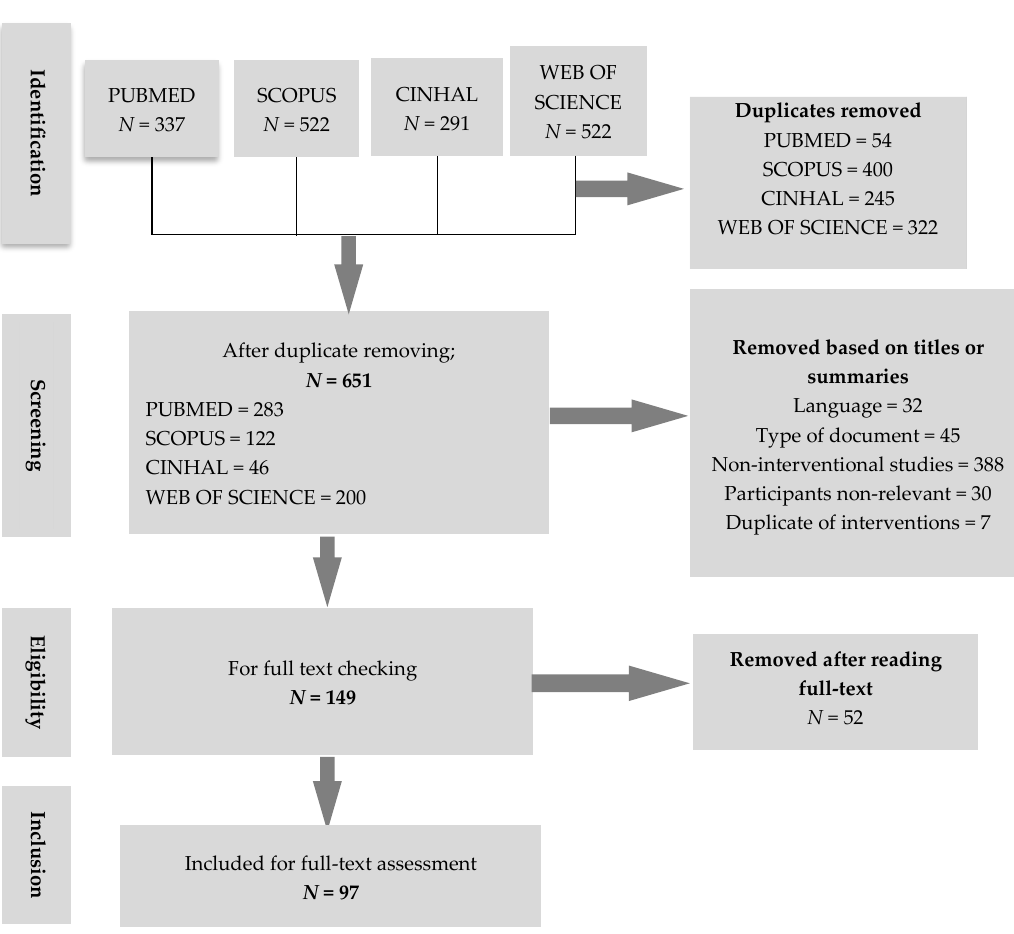
Figure 2. Distribution of included articles and interventions with involvement according to continent of publication.